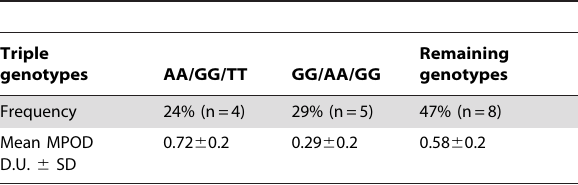
Table 2. Genotype frequencies of BCMO1 triple genotypes (rs11645428, rs6420424 and rs6564851) and mean